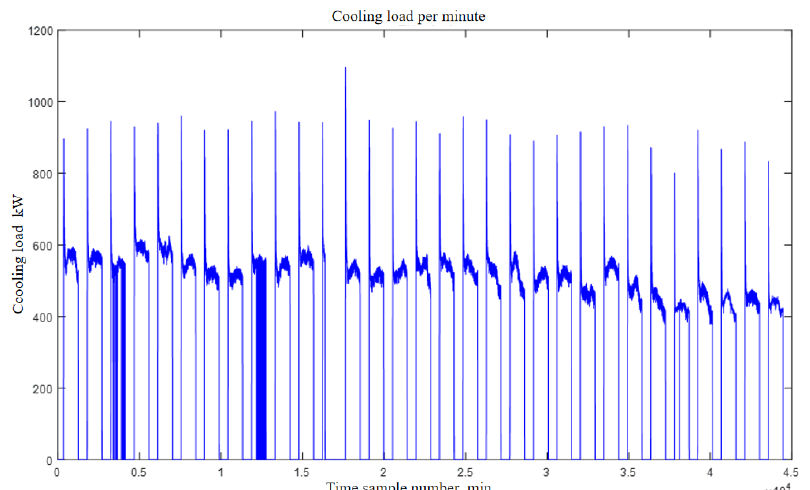
Figure 7. Full sample of cooling load per minute.